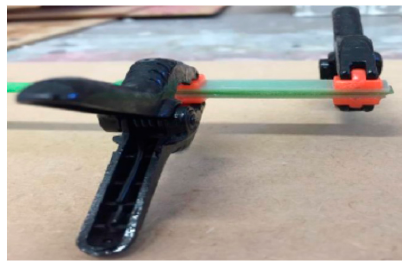
Figure 7. Detail of the epoxy tabs glued at both ends of the specimens.